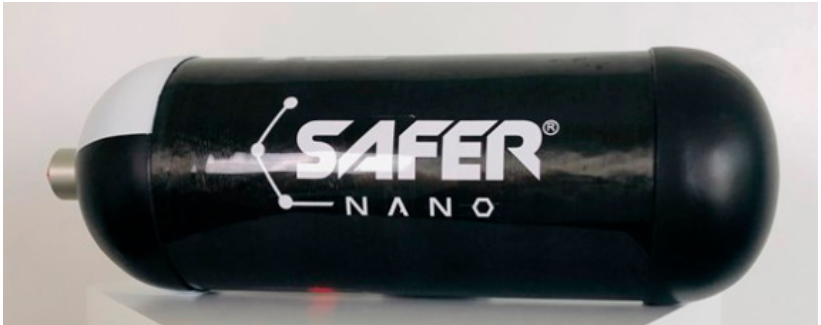
Figure 14. CNT-enhanced composite tanks [74].